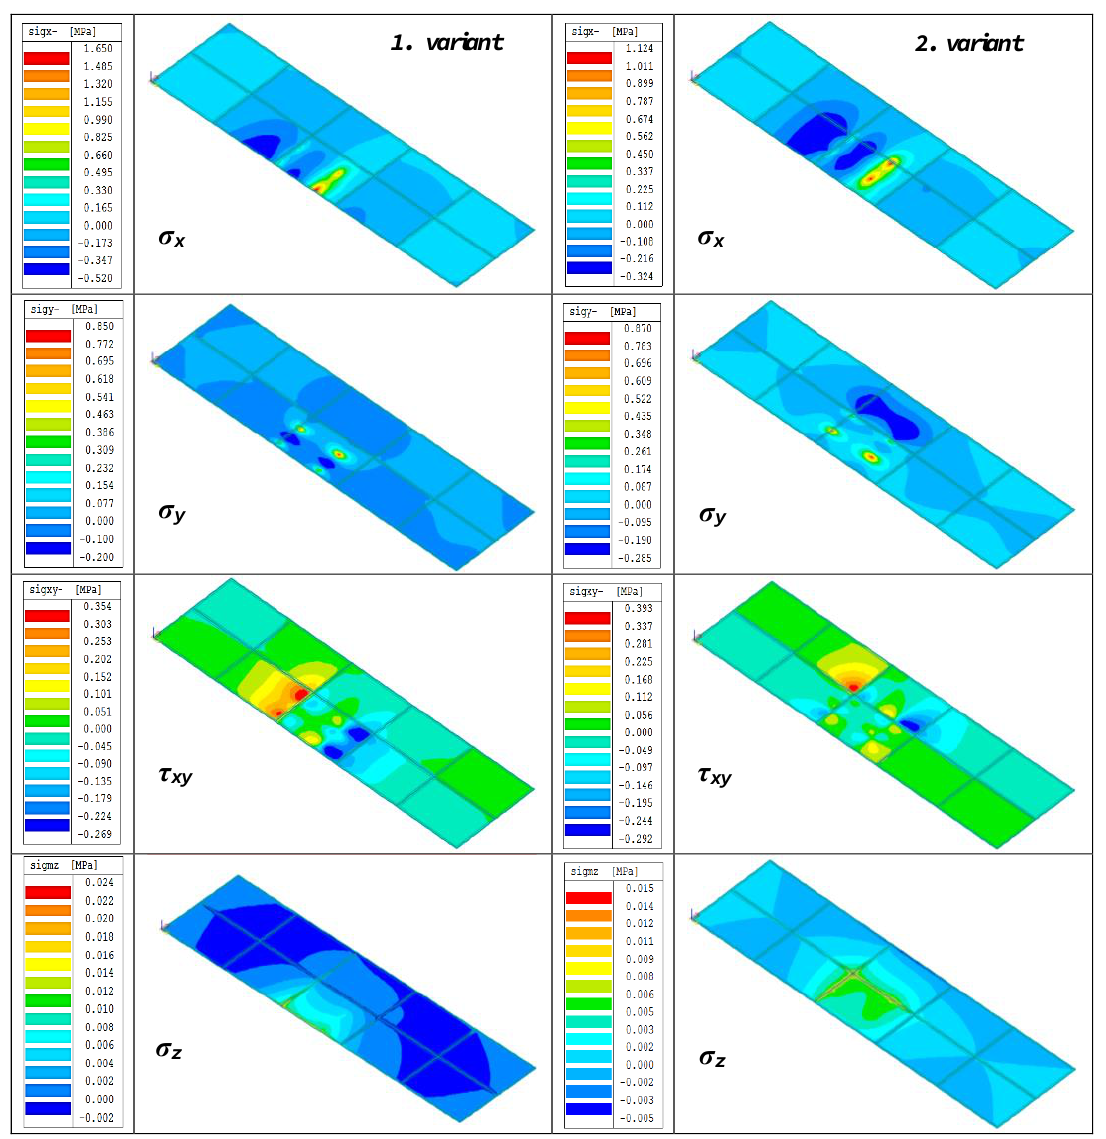
Figure 15. Numerical results — stresses. Table 4. Numerical results — maximal values and limit values according to standard TP 098.